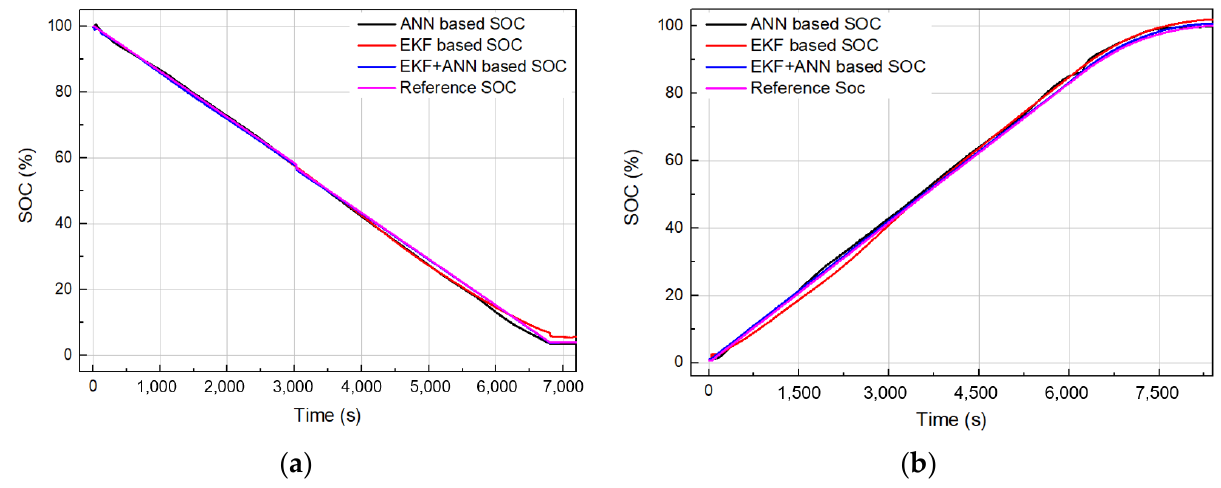
Figure 18. Experiment results of the SOC estimations using three methods: ( a ) Discharge; and ( b ) Charge.